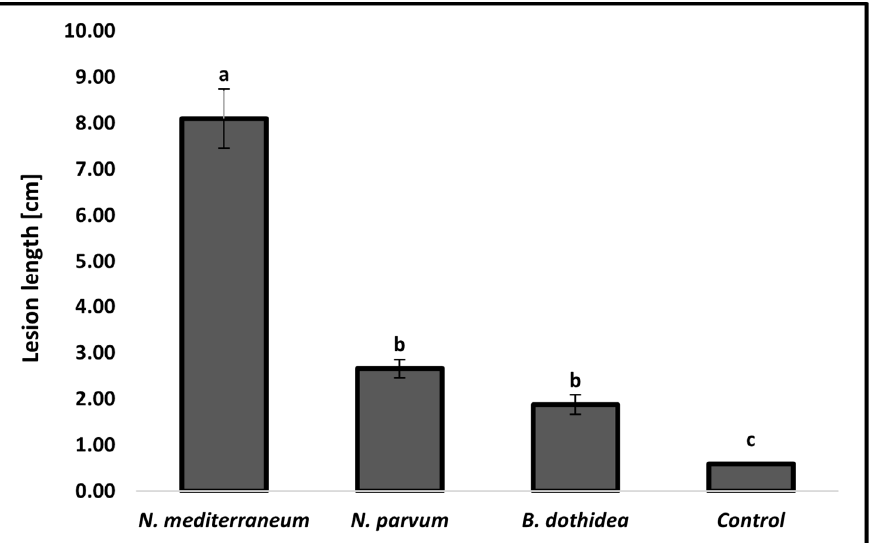
Figure 5. Comparisons of average lesion length (cm) resulting from pathogenicity test among B. dothidea , N. mediterraneum and N. parvum on potted plants. Columns are the means of 15 inoculation points (five per plant) for each fungal species. Control consisted of 12 inoculation points. Vertical bars represent the standard error of the means. Bars topped with different letters indicate treatments that were significantly different according to Fisher’s protected LSD test ( α = 0.05).